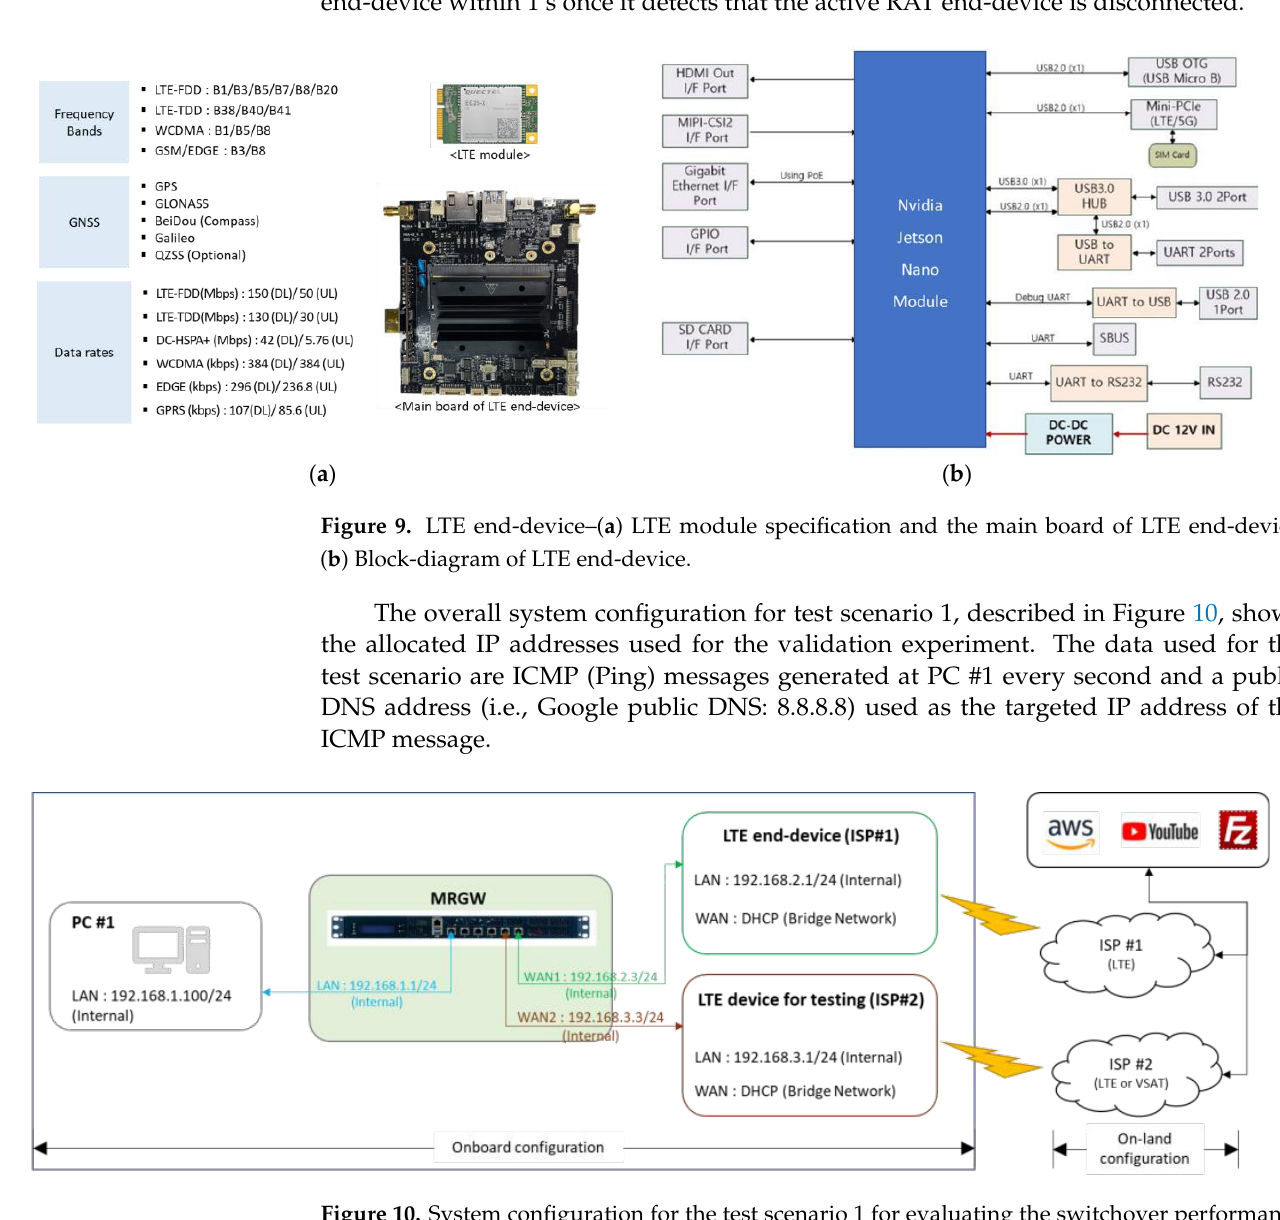
Figure 9. LTE end-device – ( a ) LTE module specification and the main board of LTE end-device; ( b ) Block-diagram of LTE end-device.